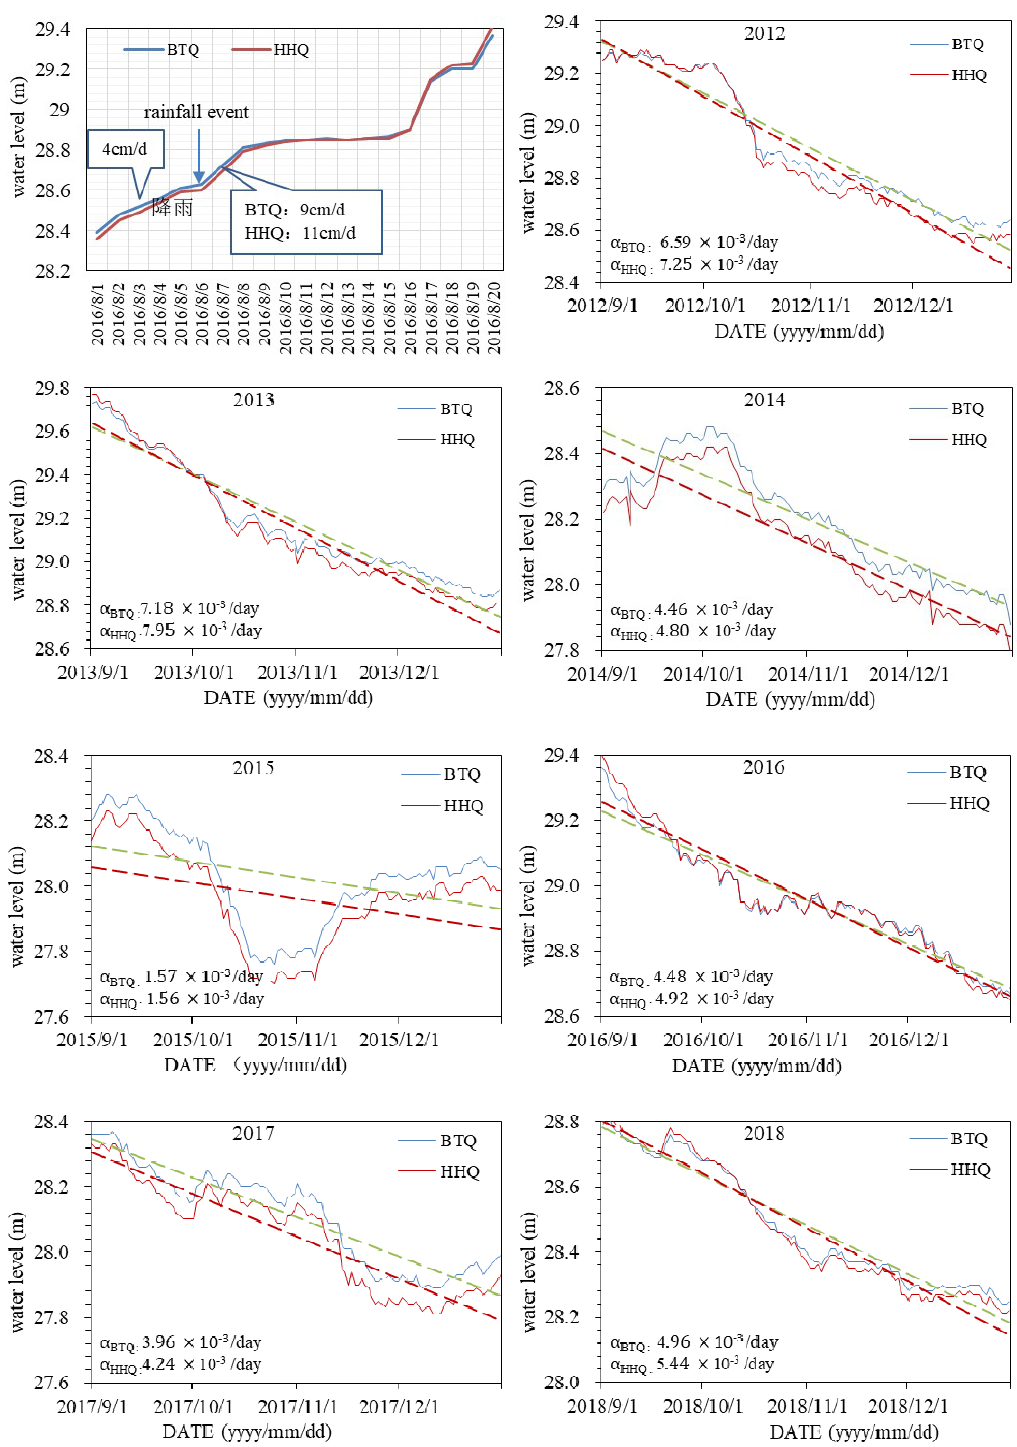
Figure 11. The water level response to rainfall event and the depletion hydrograph in BTQ and HHQ.